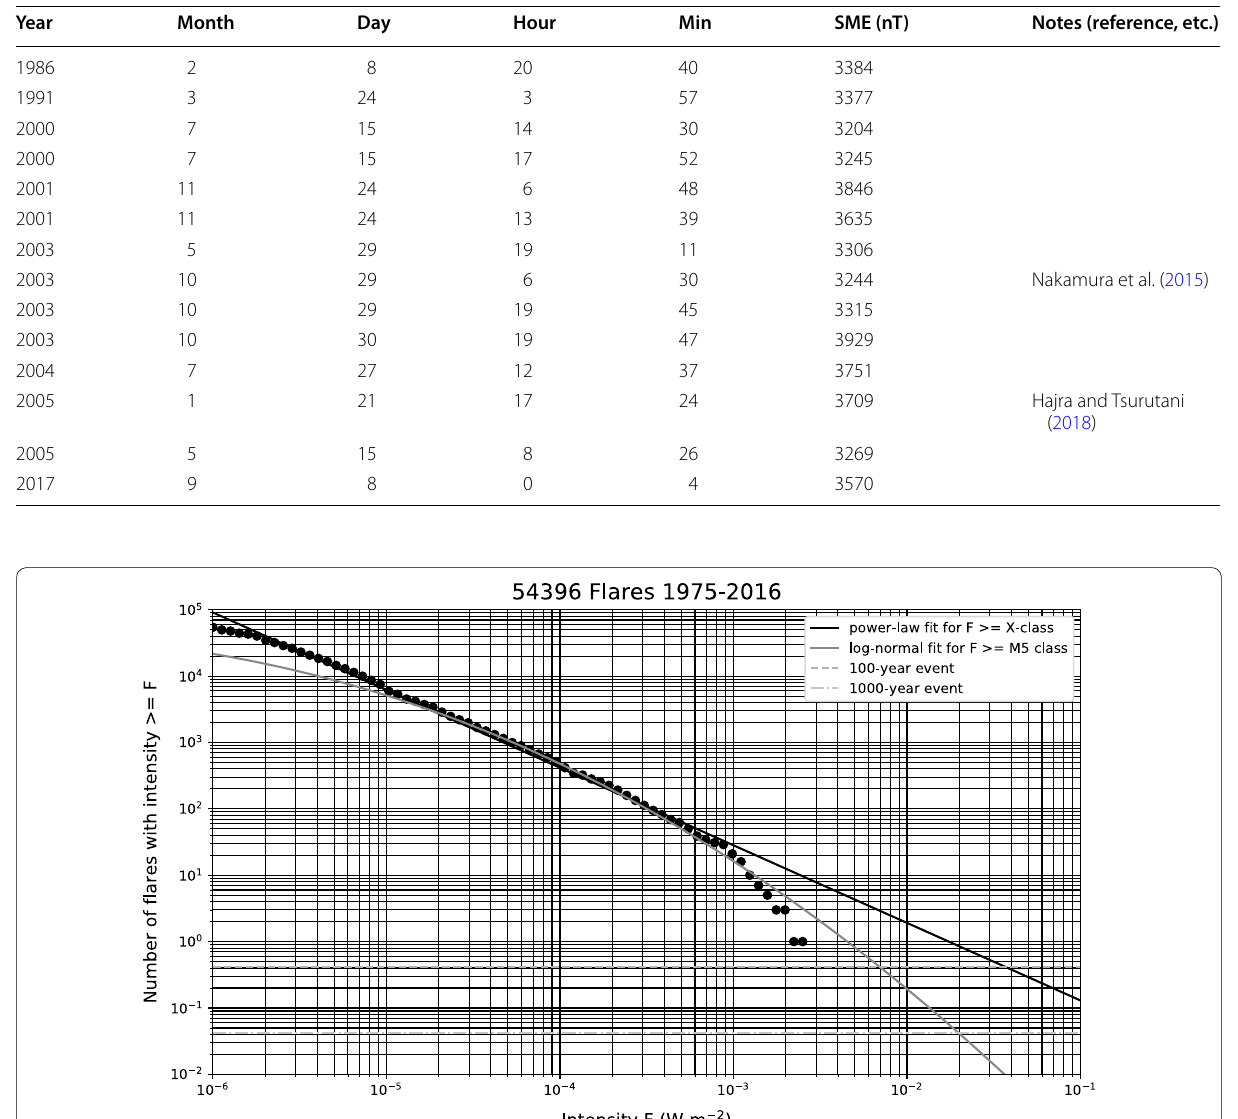
Table 3 Largest substorm events of SME > 3000 nT since 1986